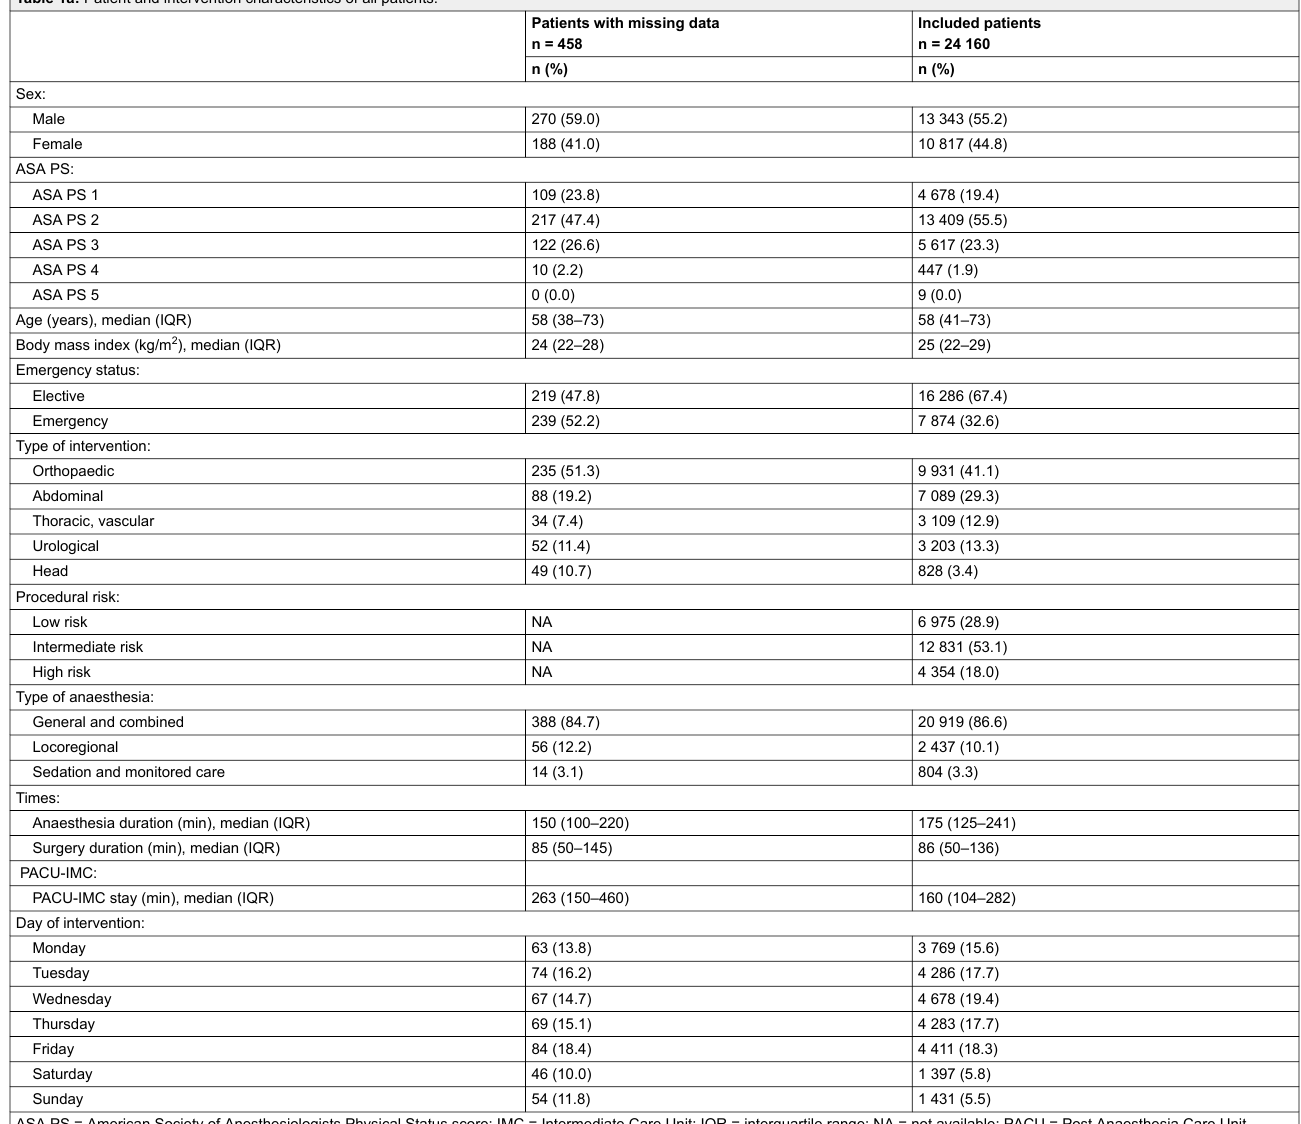
Patients with missing data n =